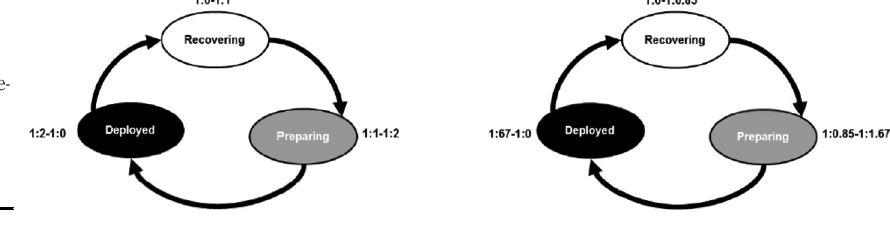
Figure 5. Four- force package model (left) and four- force package model with overlap (right)